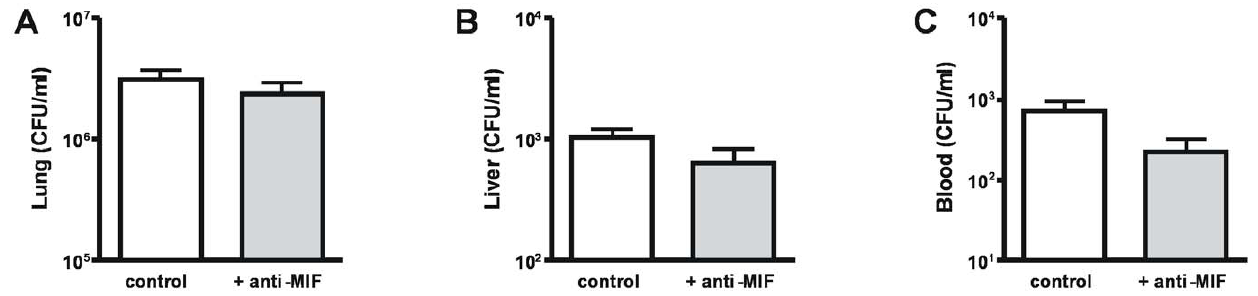
Figure 5. Effect of anti-MIF antibodies on bacterial clearance. Mice were treated with non-immune IgG control (white bars) or anti-MIF antibodies (grey bars) and inoculated with 2.5 6 10 2 CFU B. pseudomallei intranasally after which bacterial outgrowth in the lungs ( A ), liver ( B ) and blood ( C ) was analysed 48 hours later. Data represent mean 6 SEM of n=8 mice per group.